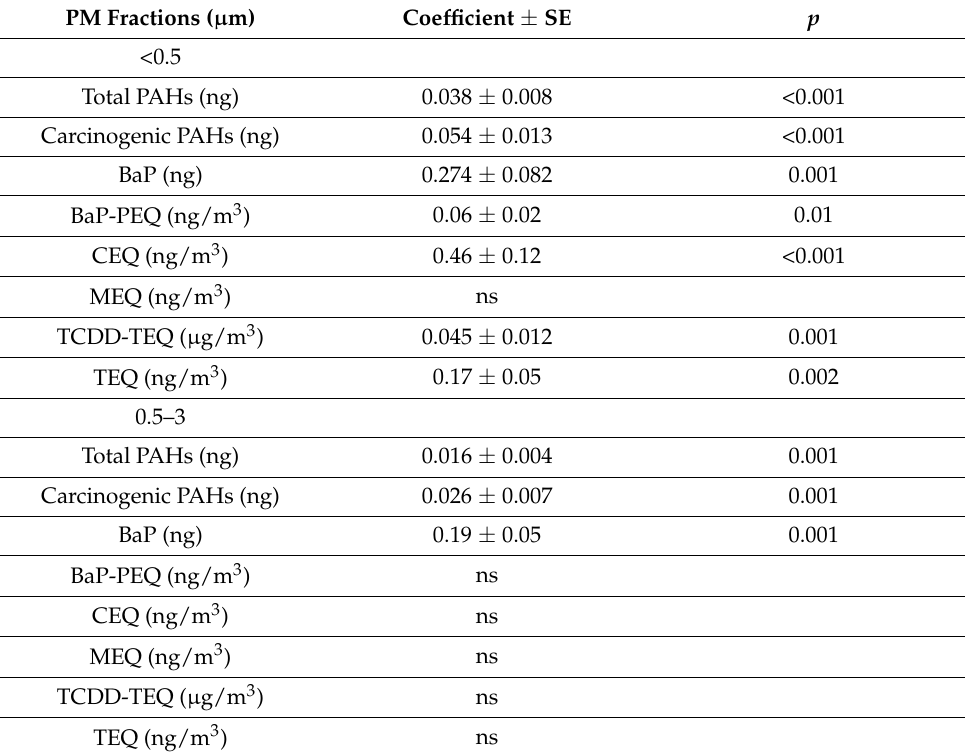
Table 5. Coefficients of the linear regression ( ± SE) of MN in children’s mucosa buccal cells according to the concentration and various measures of toxic equivalency of PAHs in each PM